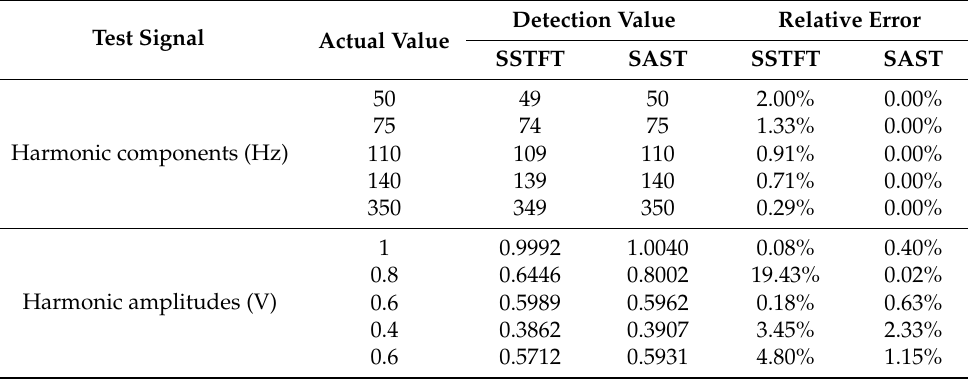
Figure 3. The results of time-varying interharmonic signals based on five methods. ( a ) Test signal, ( b ) WT, ( c ) HHT, ( d ) synchrosqueezing STFT (SSTFT), ( e ) S-transform (ST), ( f ) synchrosqueezing adaptive S-transform (SAST). Table 1. Accuracy of two methods in detecting time-varying